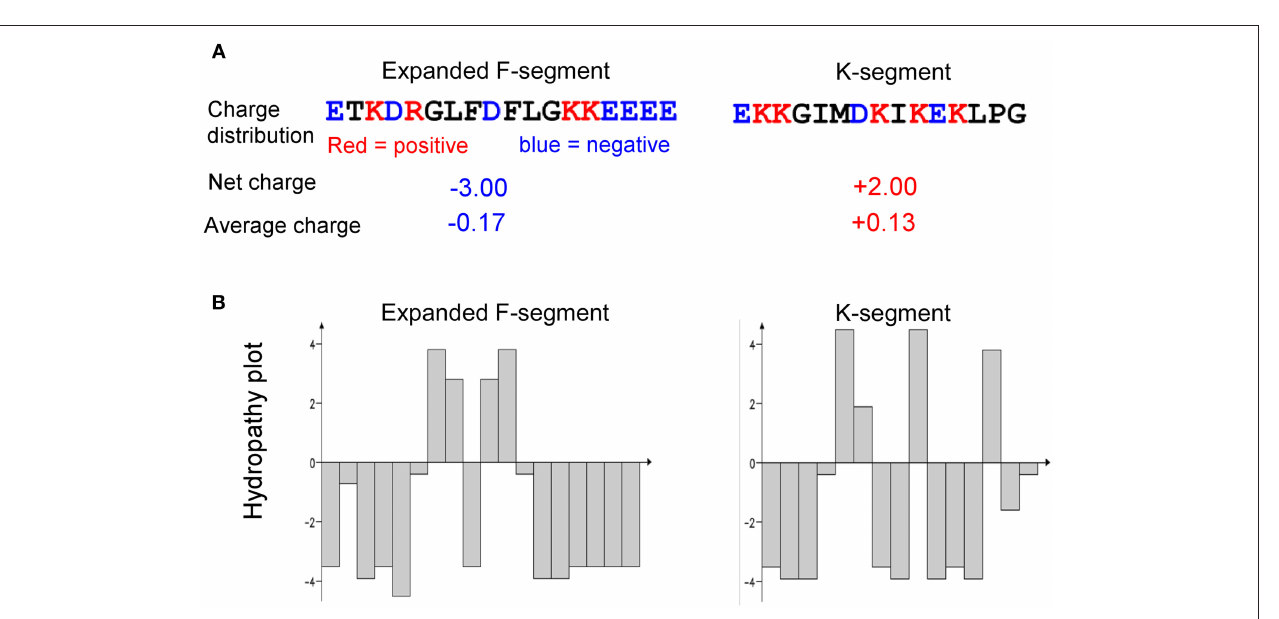
FIGURE 9 | Comparison of charge and hydropathy between the expanded F-segment and K-segment. (A) Charge profiling. (B) Hydropathy plot. K-segment was reported in literature as described in the